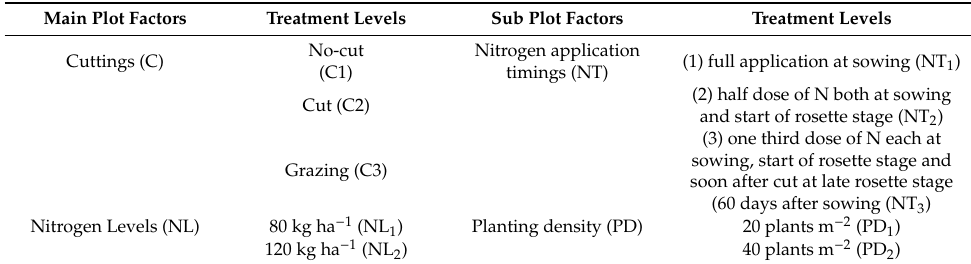
Table 1. The detailed presentation of experimental treatments.